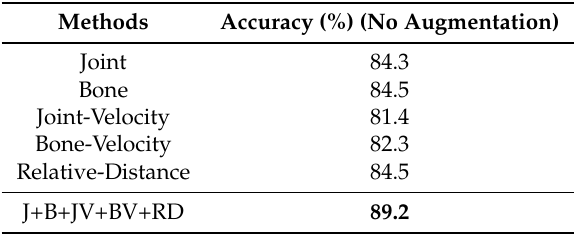
Table 4. Comparisons of the validation accuracy with different input modalities on cross-setup benchmark of NTU-RGBD-120 dataset.